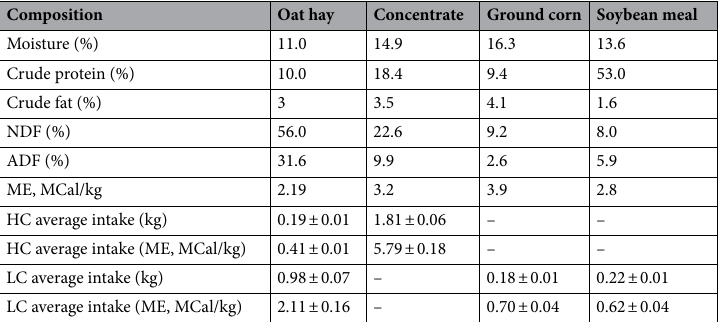
Table 1. Composition of feeds expressed as dry matter. Crude protein intake was maintained at ~ 15% of the dietary intake for both the LC and HC rations. Values represent mean ± SD as relevant. ADF acid detergent fiber, NDF neutral detergent fiber, ME metabolizable